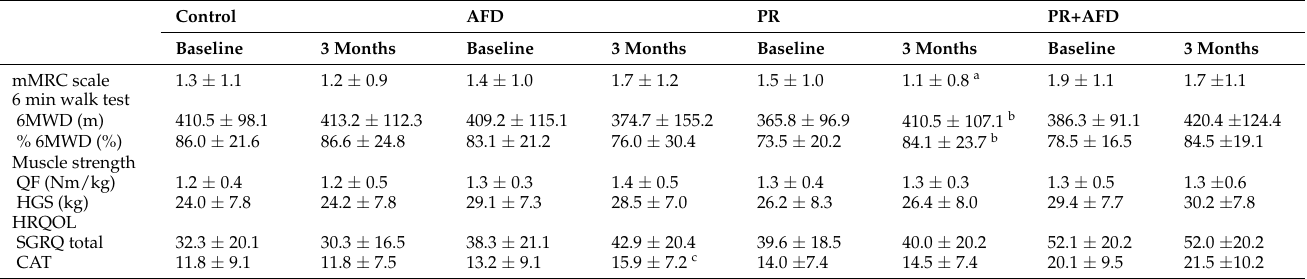
Table 2. Comparison of results at baseline and 3 months in each